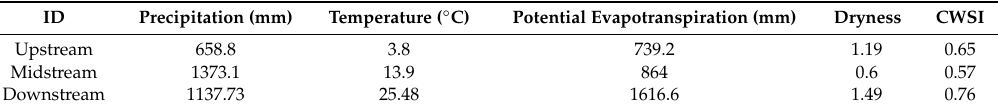
Table 1. Climatic characteristics of the